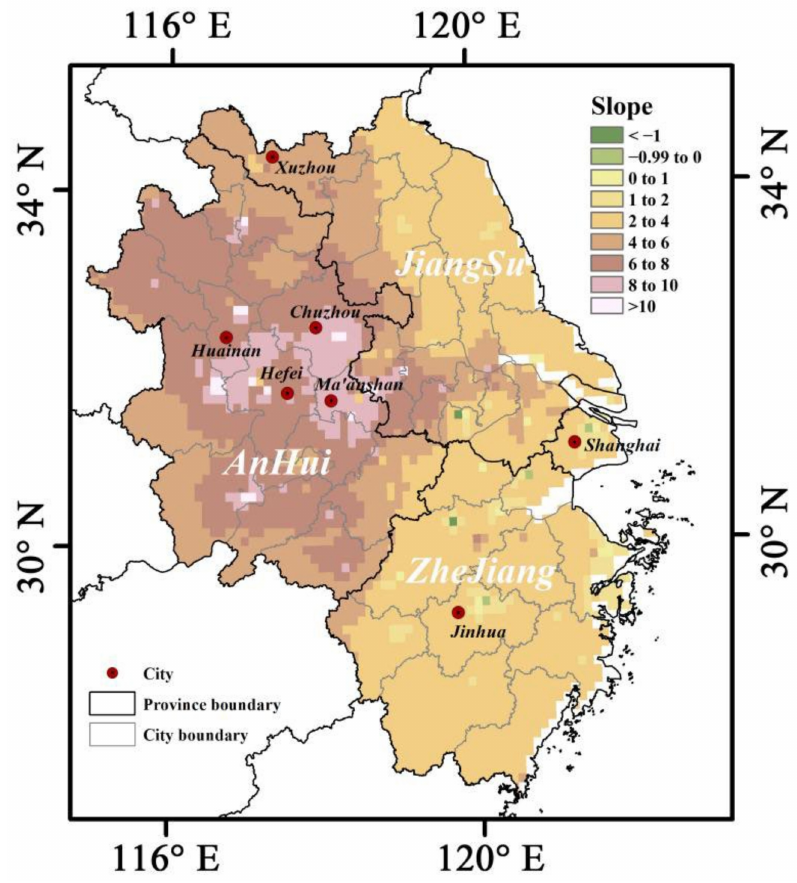
Figure 7. Trends in O 3 concentrations in the